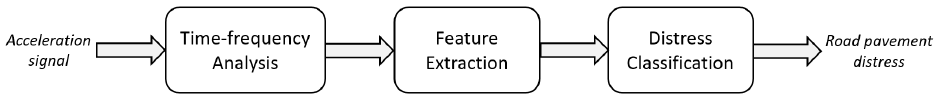
Figure 1. Block diagram of the proposed